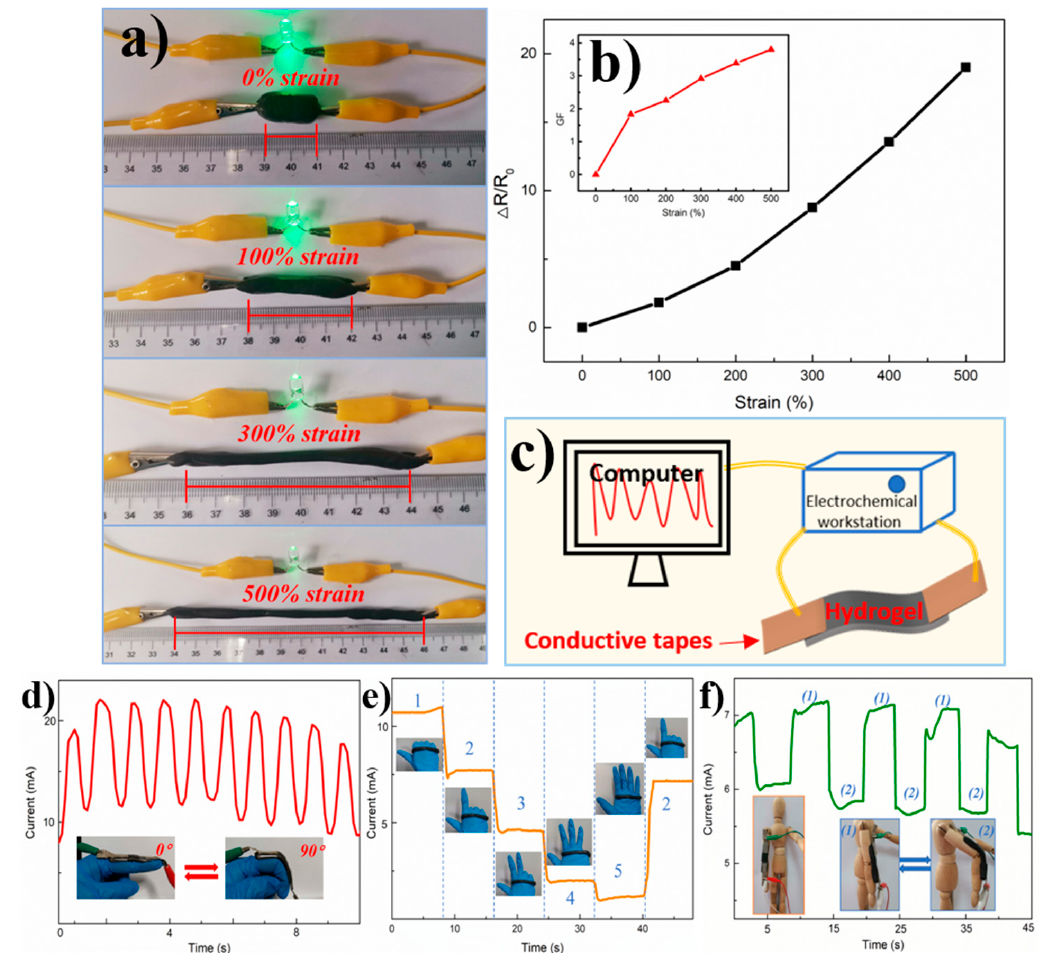
Figure 8. ( a ) Demonstration of the variations for light-emitting diode (LED) illumination vs different strain of the GN-CNF@PVA gels in a closed circuit; ( b ) the corresponding resistance variations due to the strain; ( c ) schematic illustration of strain sensor: current change of the GN-CNF@PVA hydrogels responding to rapidly finger bending ( d ) and various hand gestures ( e ); ( f ) the recorded current variations of the GN-CNF@PVA hydrogel-based strain sensor in arm bending.